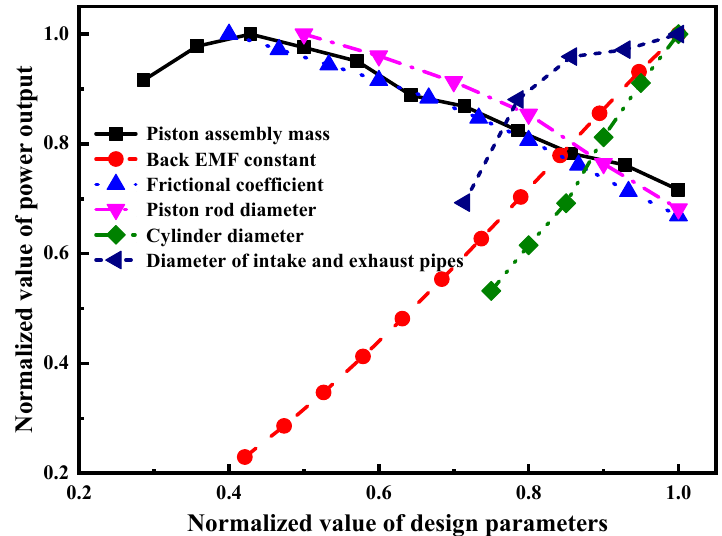
Figure 17. Influence of design parameters on operating frequency.